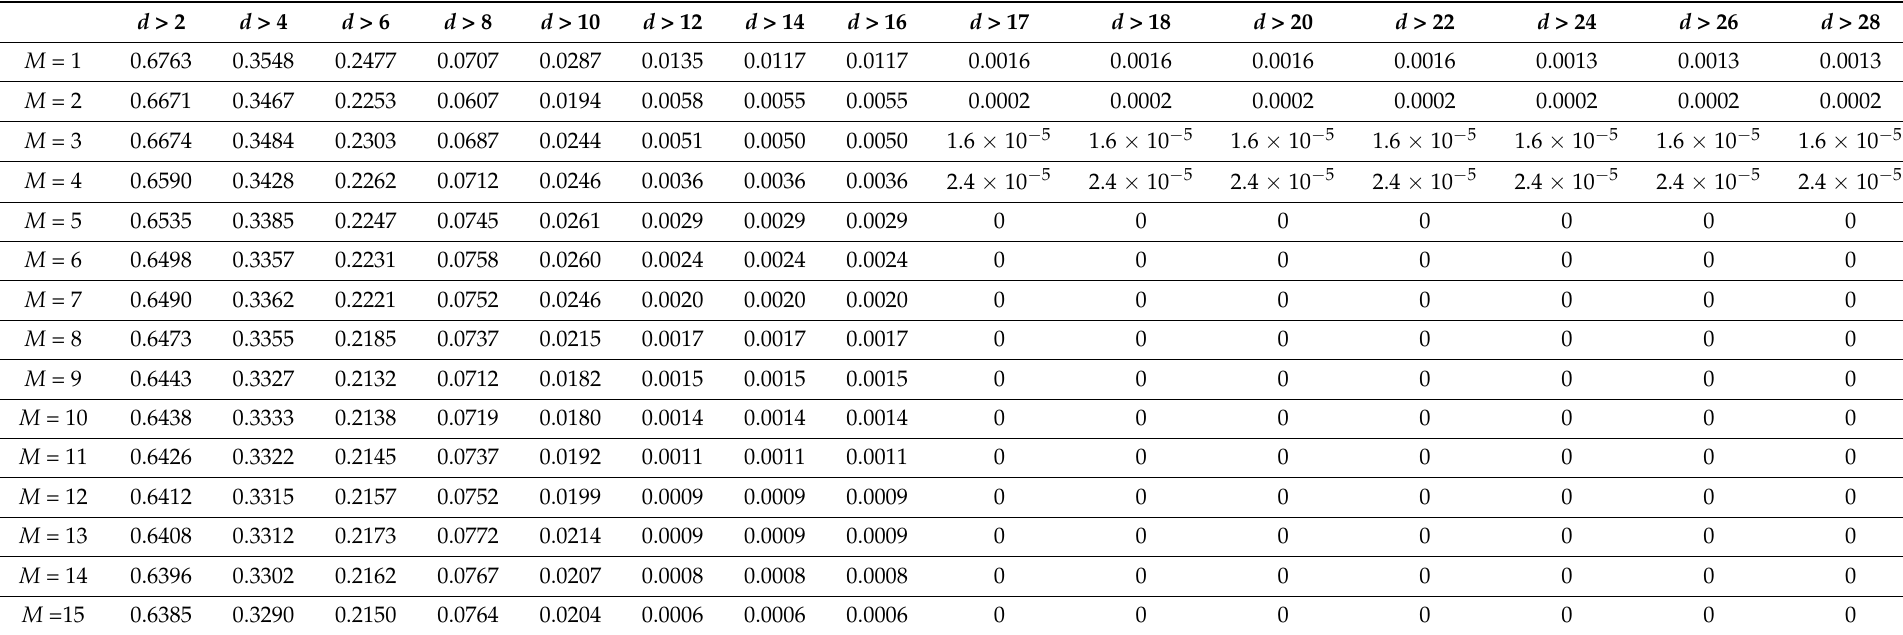
Table 9. The probability of assigning a locator node distant to the wristband by at least d